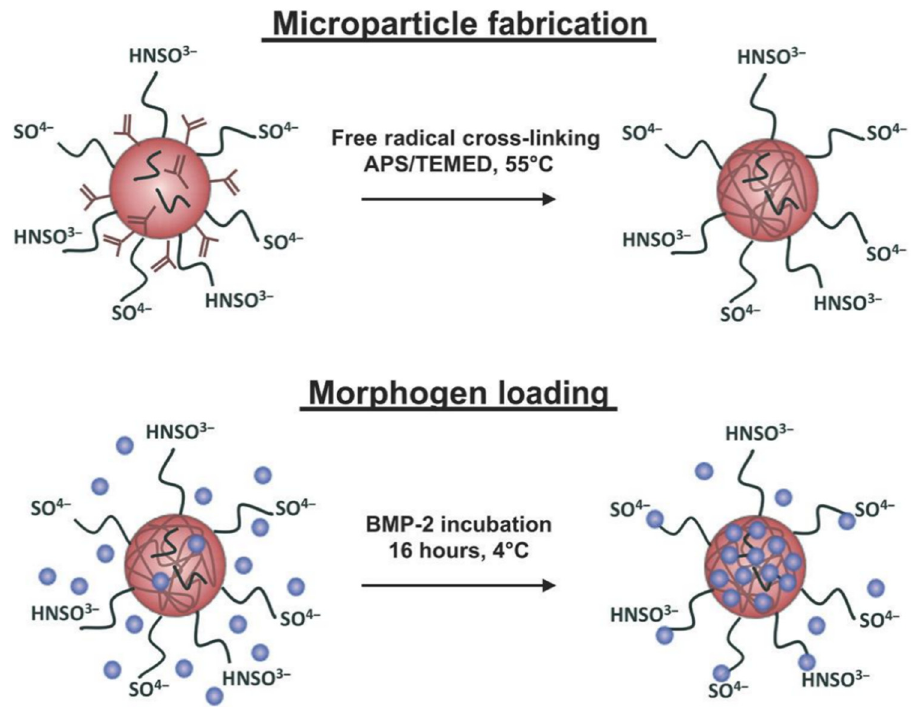
Figure 3. Fabrication of heparin microgels and their loading with human bone morphogenetic protein-2. Heparin methacrylamide was used to fabricate the microgels in a water-in-oil emulsion. APS/TEMED refers to the free radical initiators ammonium persulfate (APS) and tetramethylethane-1,2-diamine (TEMED), respectively. HNSO 3 − and SO 4 − are the sulfate groups on heparin that bind to BMP-2. The figure has been reproduced with permission from Science Advances [62].